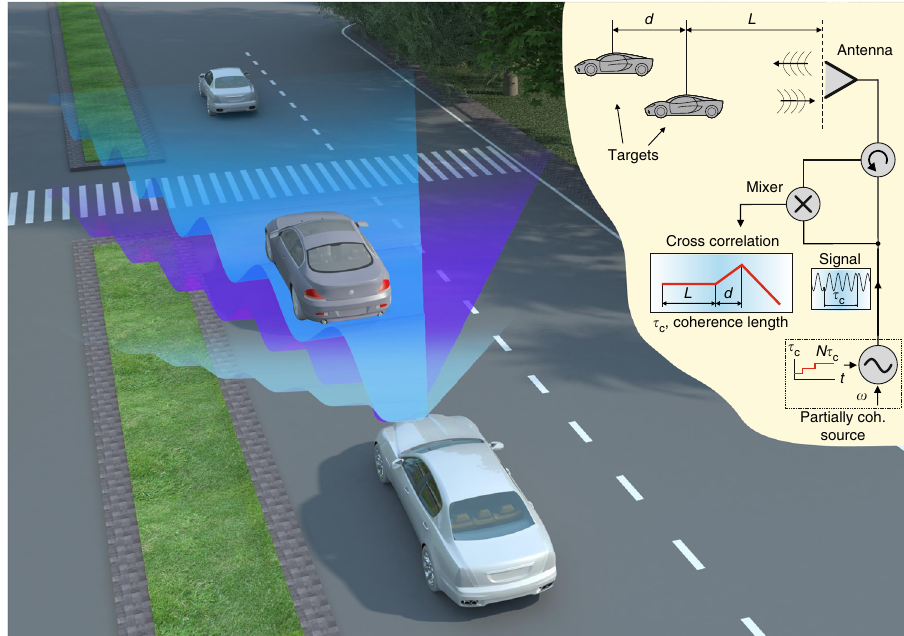
Fig. 1 Illustration of the partially coherent radar concept. Three different waves are shown: light color — smallest, purple — intermediate and blue — longest coherence lengths. The width of the beam is drawn differently for each wave solely for clarity of illustration. For the lightly colored wave, the re fl ected signal from the cars is no longer correlated with the still transmitting part of the signal, due to its short coherence length. The purple wave, re fl ected from the fi rst car, is correlated with the transmitting signal, but the re fl ections from the second car are not, which allows to detect the distance of the fi rst one. The blue wave has the longest coherence length that correlates with re fl ections from both objects, allowing the detection of the second car as well. The coherence length (or time) of the radar is swept from shortest to longest, scanning the location of targets along the line of sight. Inset — Schematic representation of the radar system. An oscillator with controllable coherence time τ c is transmitted and mixed with the re fl ections from the targets. The phase is switched N times and the output of the mixer is averaged over a window of length N τ c . Repeating the process by sweeping over the coherence length produces the cross-correlation as a function of coherence length. The location of the targets is extracted from this